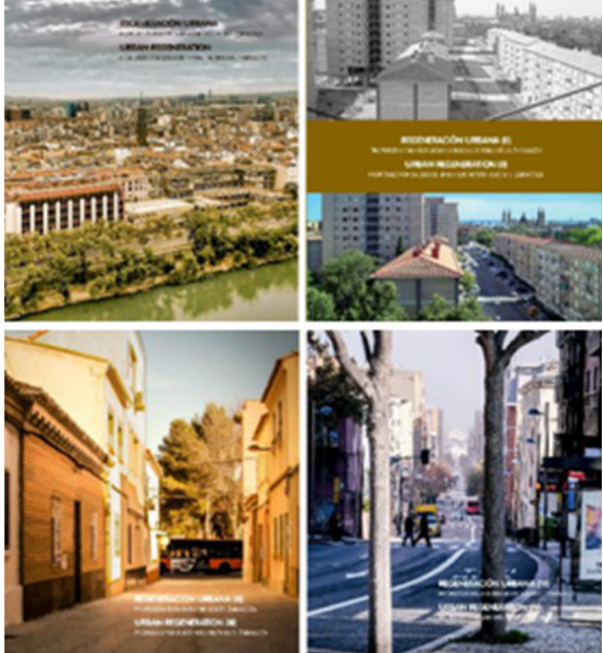
Figure 9. Results of these five academic years published in the collection Regeneración urbana vol. I, II, III, IV (the fifth volume is being prepared) focused on the city of Zaragoza, specifically the San Pablo neighbourhood (2013-14), the Balsas de Río Ebro housing estate (2014-15), and the Oliver (2015-16) and San José neighbourhoods (2016-17). Zaragoza: PUZ